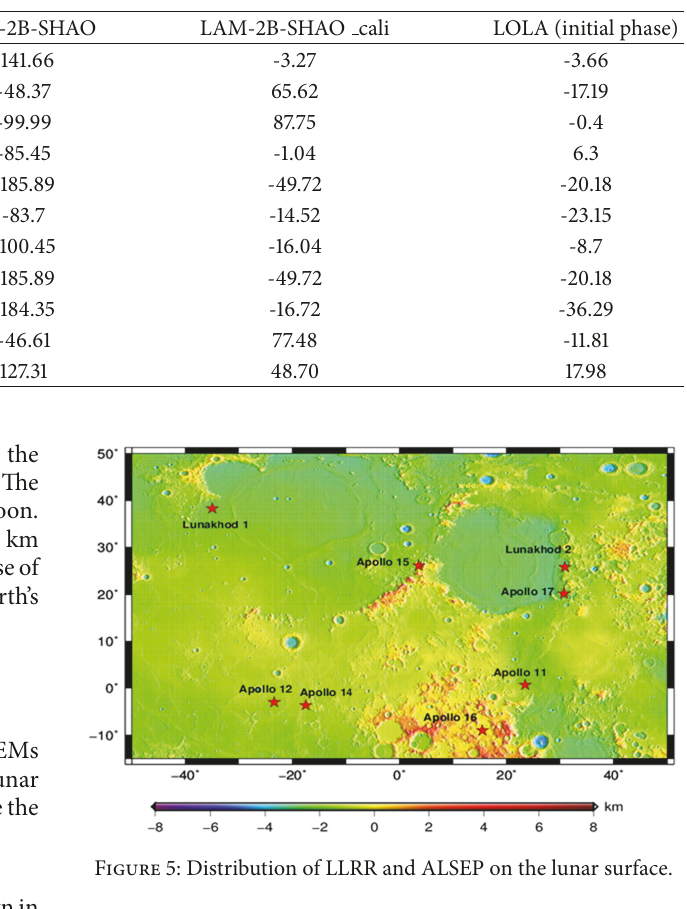
Table 4: LLRR and ALSEP elevation error for different DEMs.